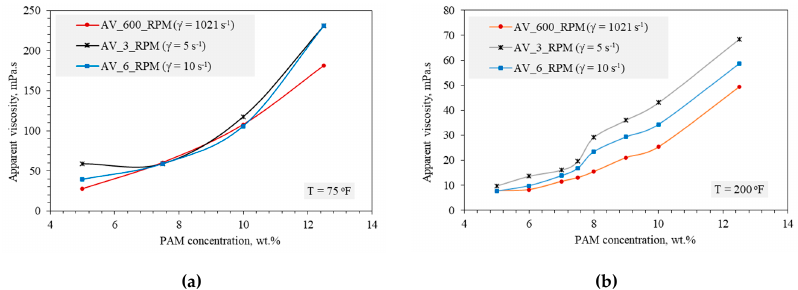
Figure 4. Impact of PAM concentration and shear rate on AV of the PAM ‐ based drilling fluid at ( a ) 75 °F and ( b ) 200 °F.